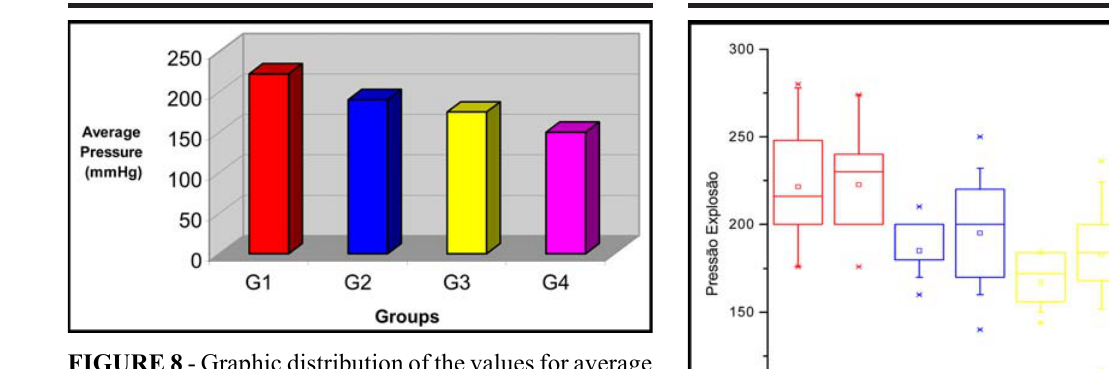
FIGURE 8 - Graphic distribution of the values for average rupture pressure by liquid distension (mmHg) for the four groups